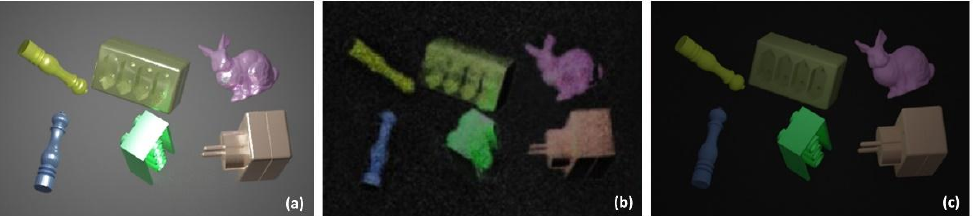
Figure 11. Image comparison using CAE network. ( a ) Specular input; ( b ) Network output; ( c ) Target diffuse.